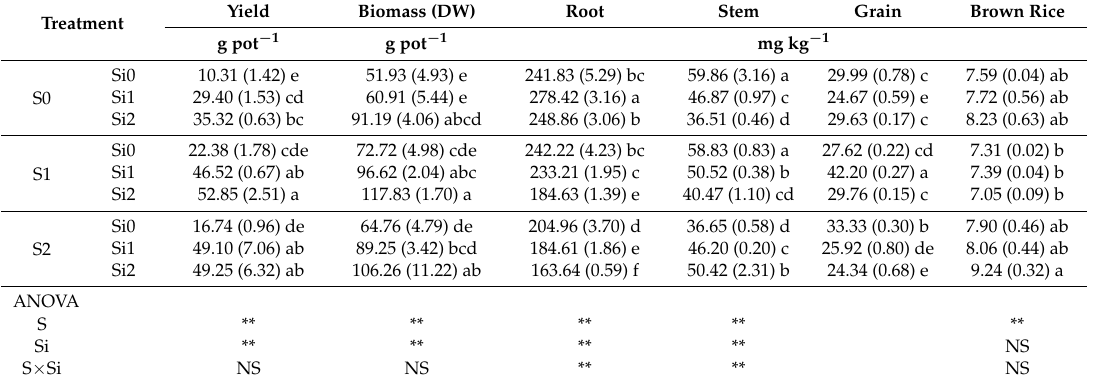
Table 3. Variations of rice yield and biomass, copper uptake by rice plant, and transfer coefficient of copper in response to the co-amendment of S and